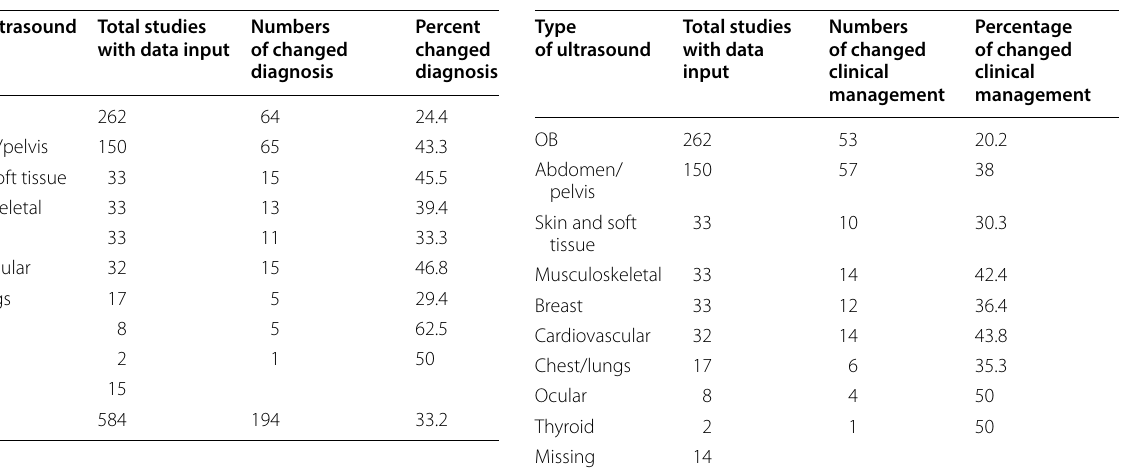
Table 4 The frequency for which POCUS changed